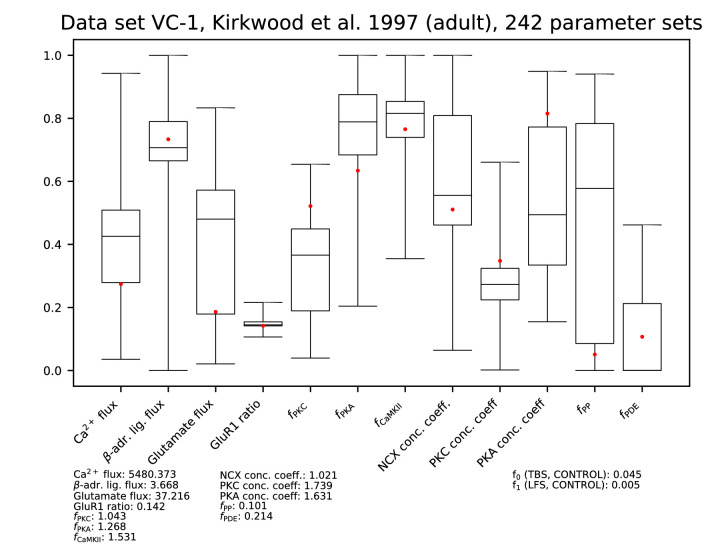
Parameters for data set VC-1.See Figure 9—figure supplement 1 for details.